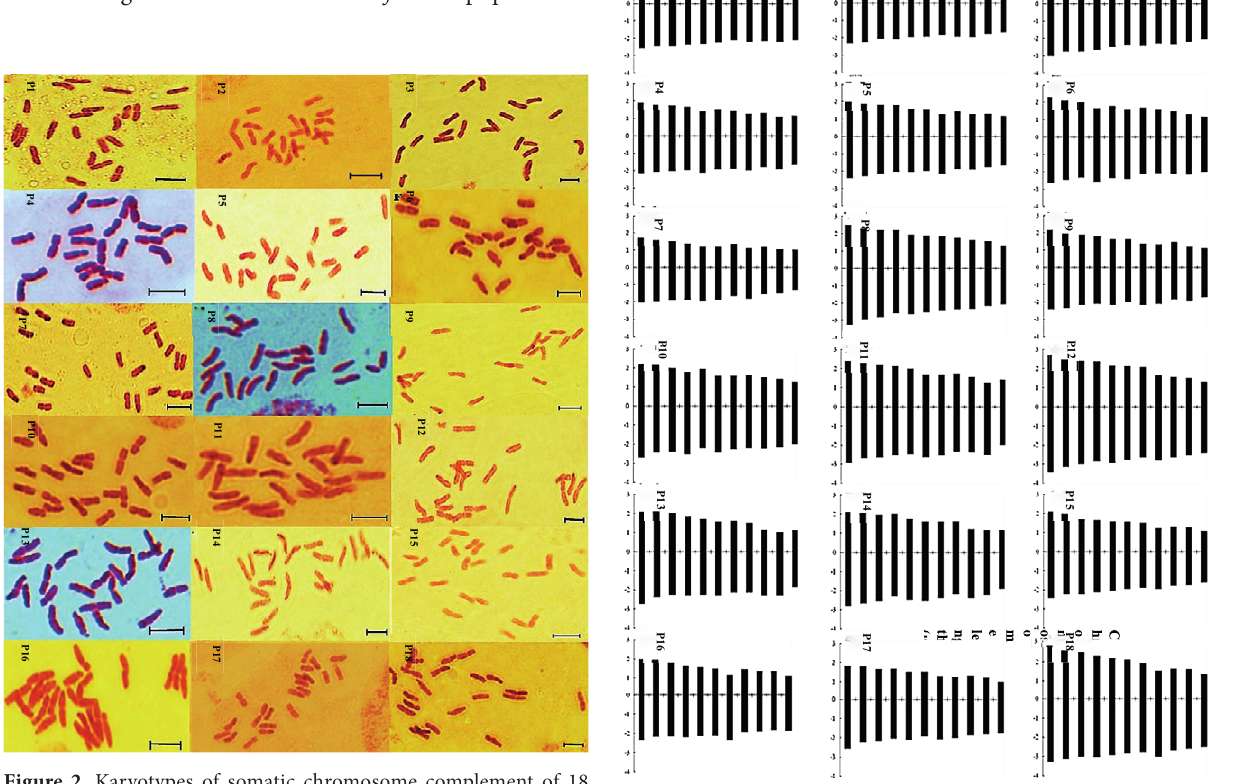
Figure 3. Idiograms of haploid chromosome complement of 18 Ira- nian endemic Ferula assa-foetida L. (2 n = 2 x = 22)